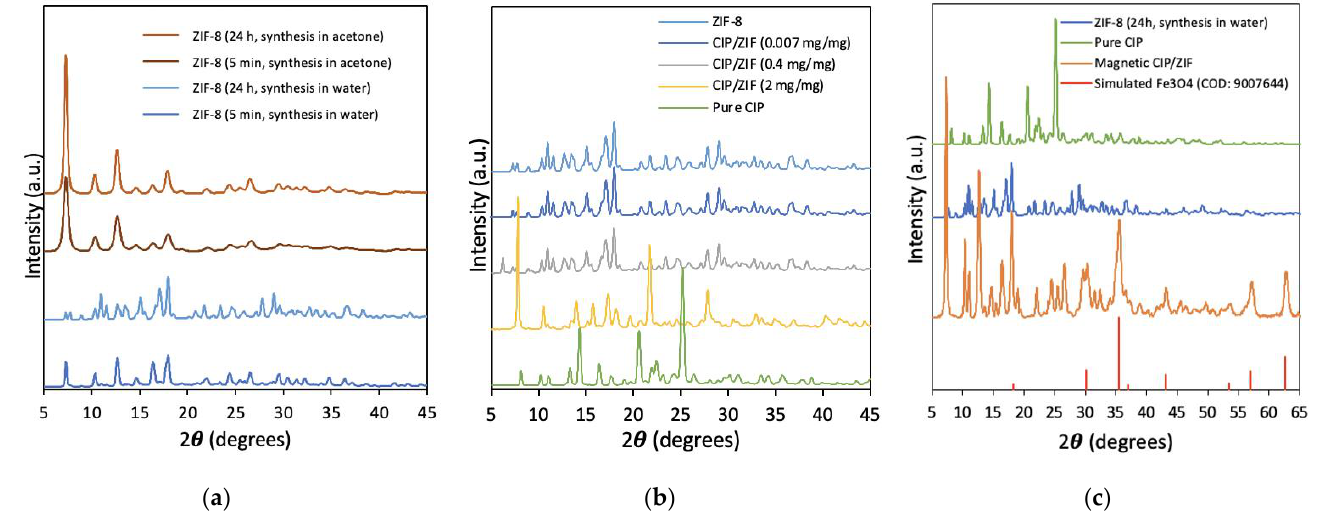
Figure 4. X-ray Diffraction patterns of ( a ) ZIF-8 with different synthesis conditions; ( b ) ZIF-8 and encapsulated CIP in ZIF-8 at different loadings; and ( c ) magnetic CIP/ZIF material.